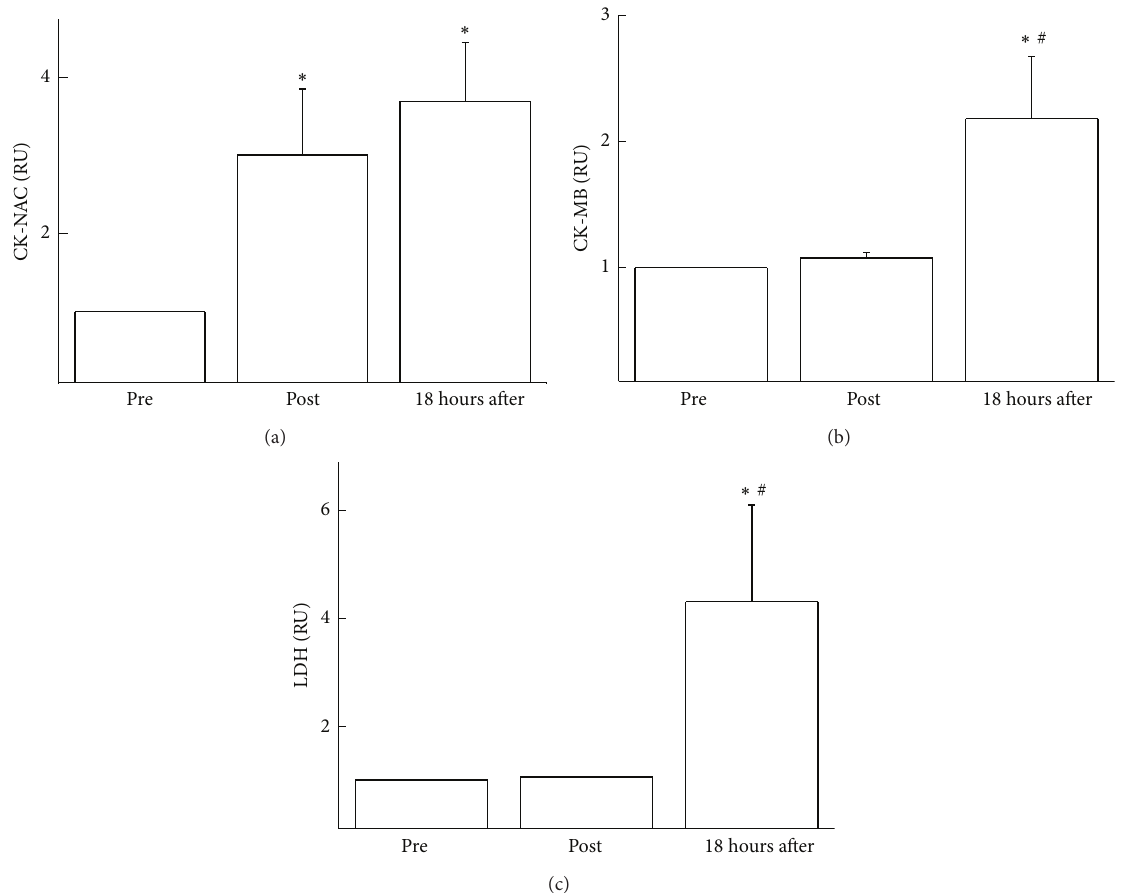
Figure 1: Effect of classical ballet on muscle lesion markers. Serum concentrations of CK-NAC (a), CK-MB (b), and LDH (c) in dancers were determined before, immediately after, and 18 hours after a ballet class. The values are presented as mean ± standard error of 13 dancers and are presented as relative unit (UR). Figures were plotted with the data of the variations in markers during a ballet class, thus indicating the normalization between the values of before and after a ballet class. ∗ 𝑃 < 0.05 for comparison to preclass condition and # 𝑃 < 0.05 for comparison to immediately after ballet class